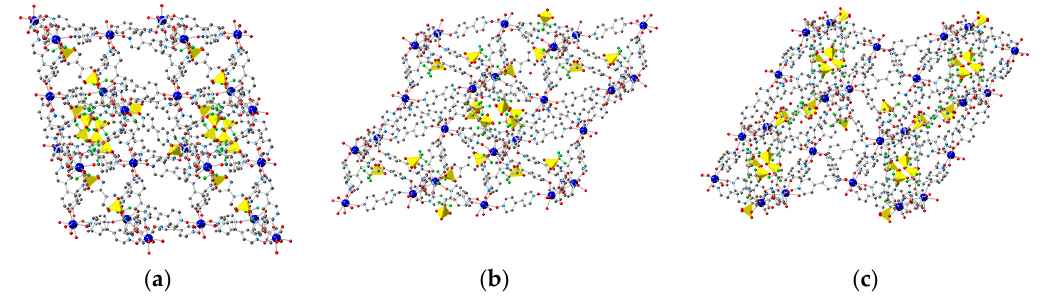
Figure 1. Crystal structure of 1 along the (100), (010) for and (001) directions, shown in ( a ), ( b ) and ( c ) respectively. Color code: Gd, deep blue ; C, grey ; N, blue ; O, red ; S, yellow ; F, green . Hydrogen atoms omitted for clarity.